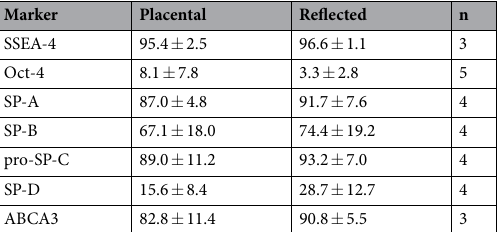
Table 1. Flow cytometric analysis of hAE cells immediately after isolation: Percentages of hAE cells isolated from the placental and reflected hAM region, positive for the respective marker. Illustrated are mean ± S.D. of given biological replicates.